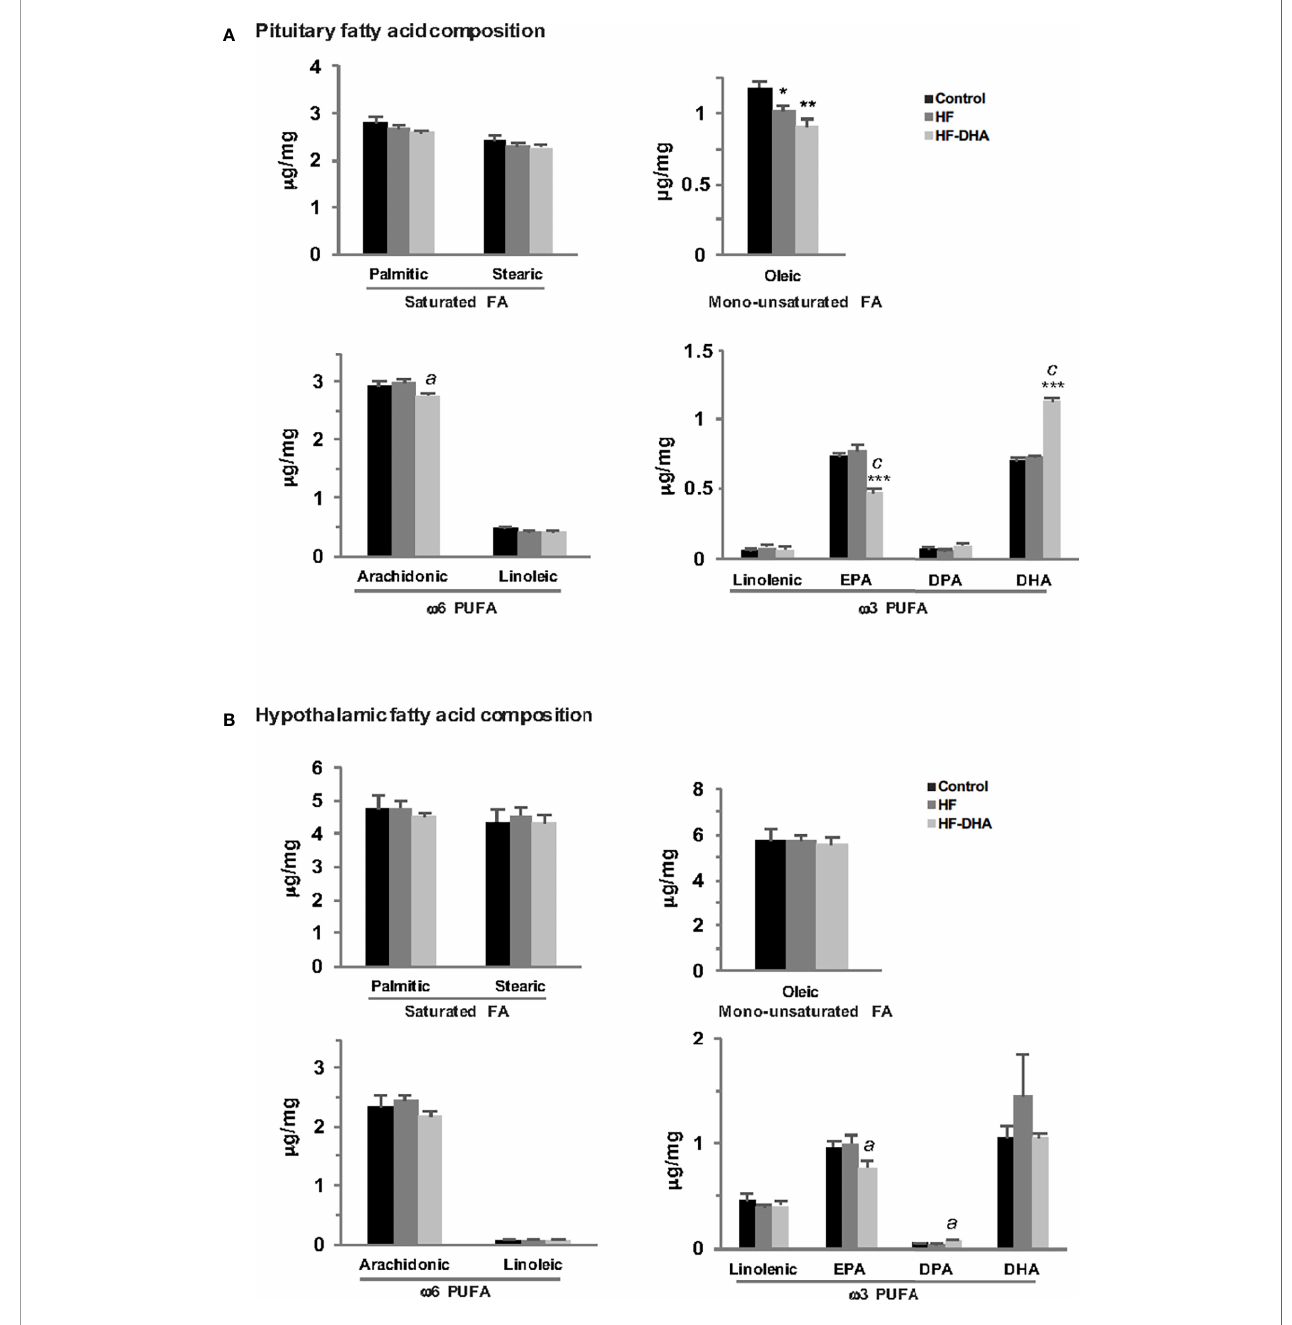
FIGURE 5 | Fatty acid composition in anterior pituitaries and hypothalamus of rats fed short-term high-fat diets. The concentration of saturated FA (palmitic and stearic acids), monounsaturated FA (oleic acid), w 6 PUFA (linoleic, arachidonic acids) and w 3 PUFA (linolenic acid, eicosapentaenoic acid (EPA), docosapentaenoic acid (DPA) and docosahexaenoic acid (DHA) were determined by GCMS as described in Materials and Methods in pituitary (A) and hypothalamus (B) of rats fed control or high-fat diets for 4 weeks. Results are expressed in m g/mg of tissue and are the mean ± SEM of 5 rats in each group. * P ≤ 0.05; ** P ≤ 0.01; *** P ≤ 0.001 compared with control group.; a P ≤ 0.05; c P ≤ 0.001 between HF and HF-DHA